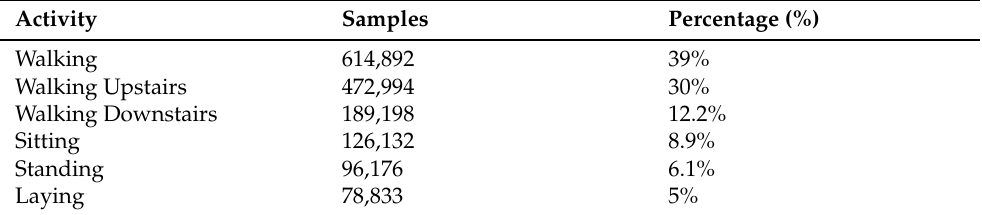
Table 2. Activities of